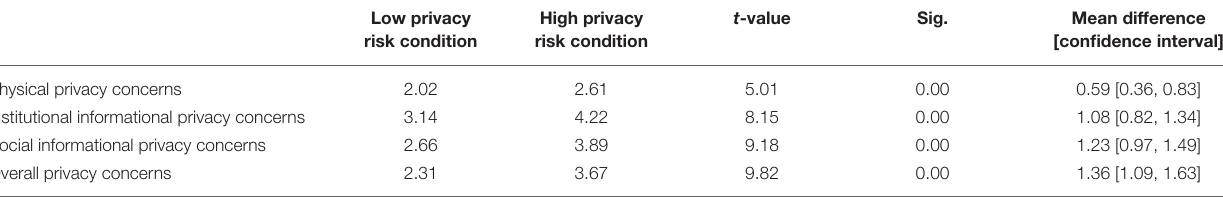
TABLE 1 | Manipulation check.